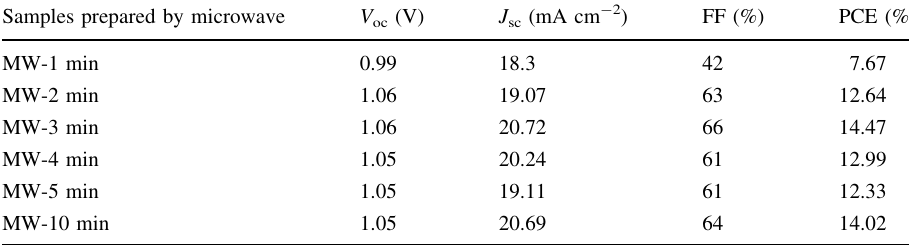
Table 2 Photovoltaic parameters of devices with different annealing processes